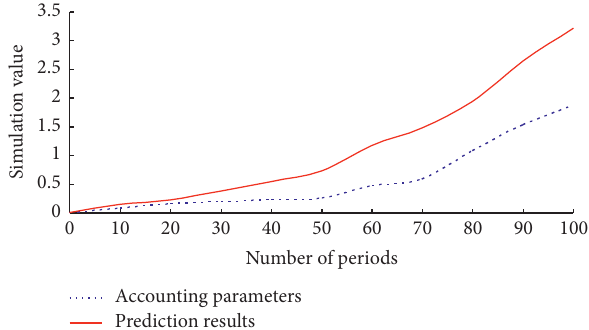
Figure 4: Dynamic changes of accounting parameters and prediction objectives with different periods.